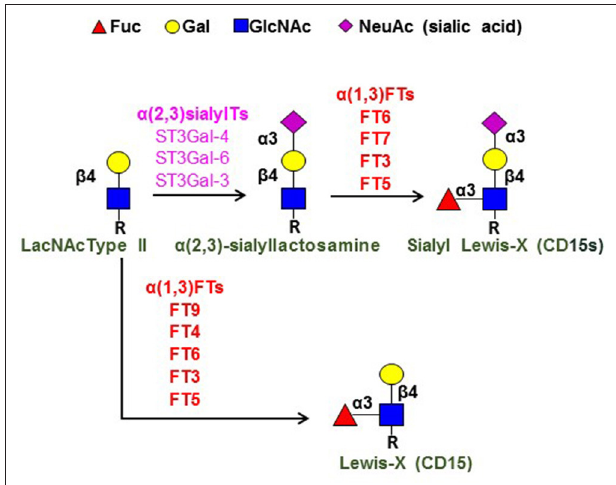
FIGURE 1 | Terminal lactosamine structures. Depicted are the structures for terminal sialylated Type 2 lactosamine (LacNAc), sialylated Lewis X (sLe X